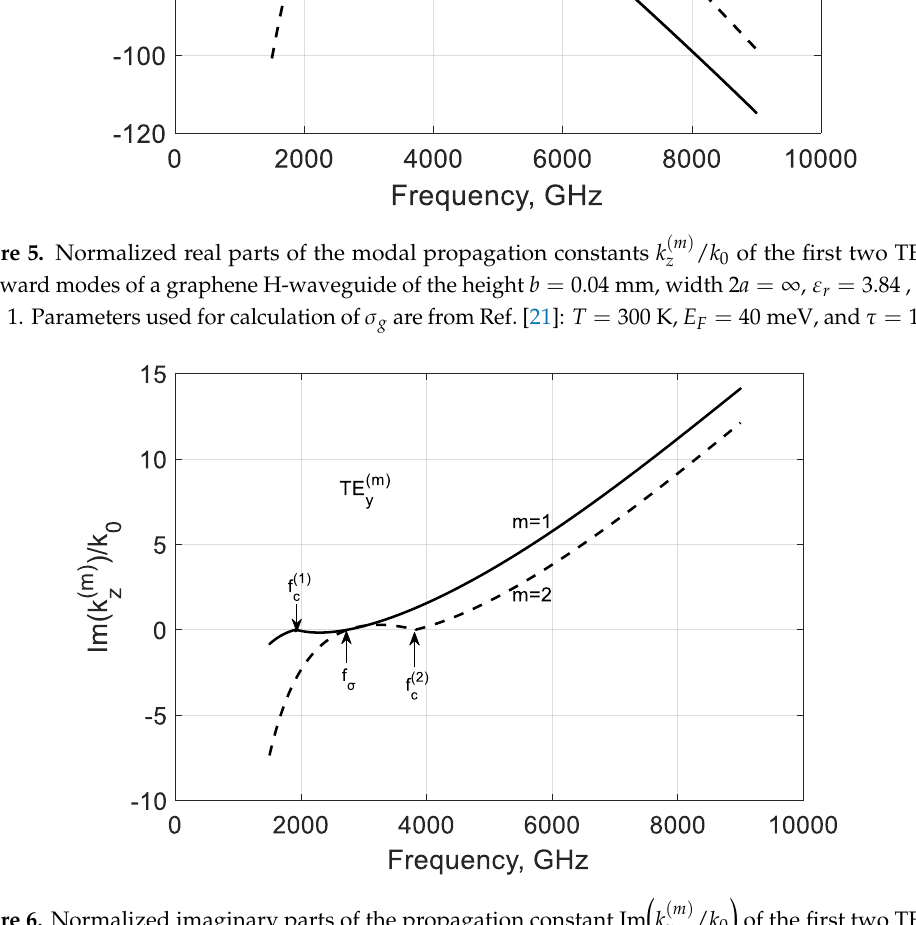
Figure 6. Normalized imaginary parts of the propagation constant Im backward modes of a graphene H-waveguide of the height b = 0.04 mm and width 2 a = ∞ , ε r = 3.84, and µ r = 1. Parameters used for calculation of σ g are from Ref. [21]: T = 300 K, E F = 40 meV, and τ = 1